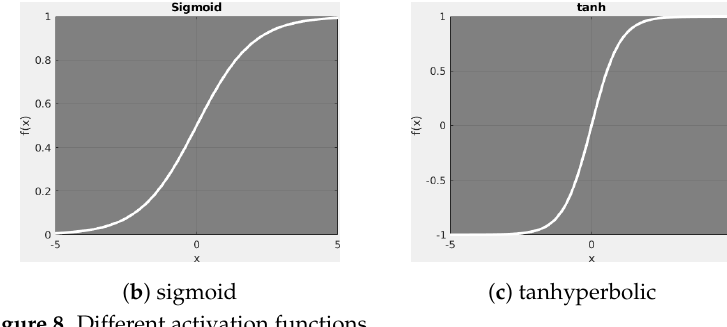
Figure 8. Different activation